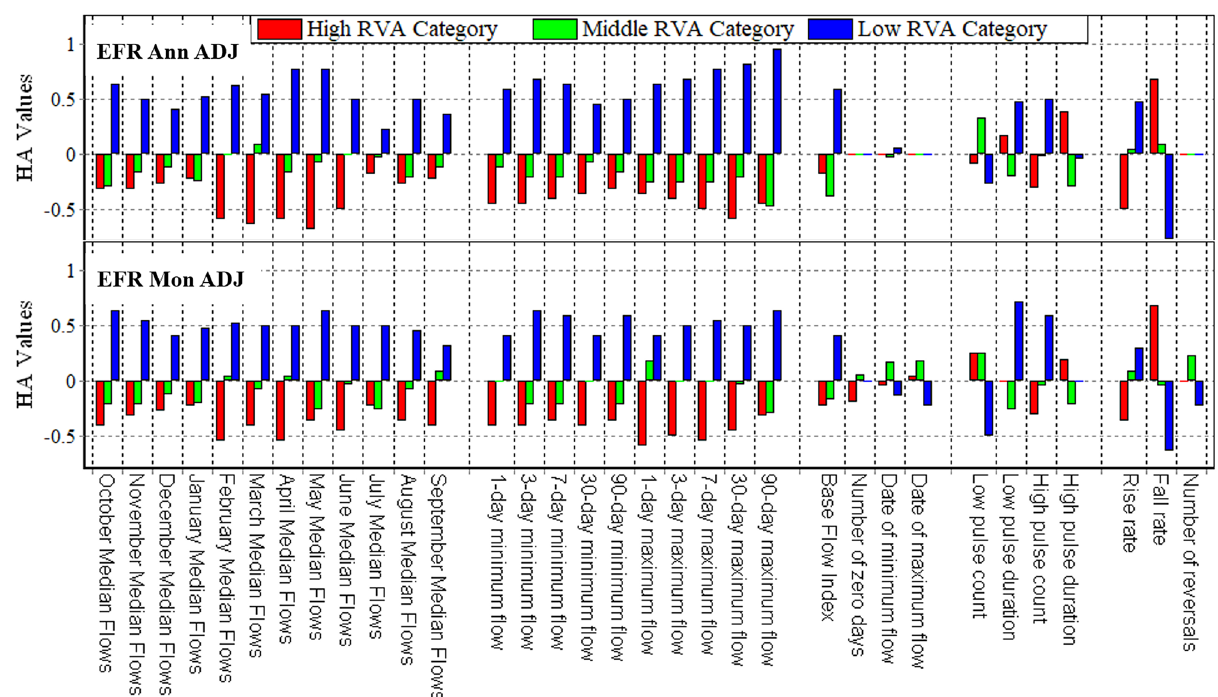
Figure 9. HA values using the RVA method for EFR allocations using adjusted annual and monthly methods at the Tapik Station, Nazlu River. HA 0 %MAFMiddle RVA Category (%) High RVA Category (%) Low RVA Category Method